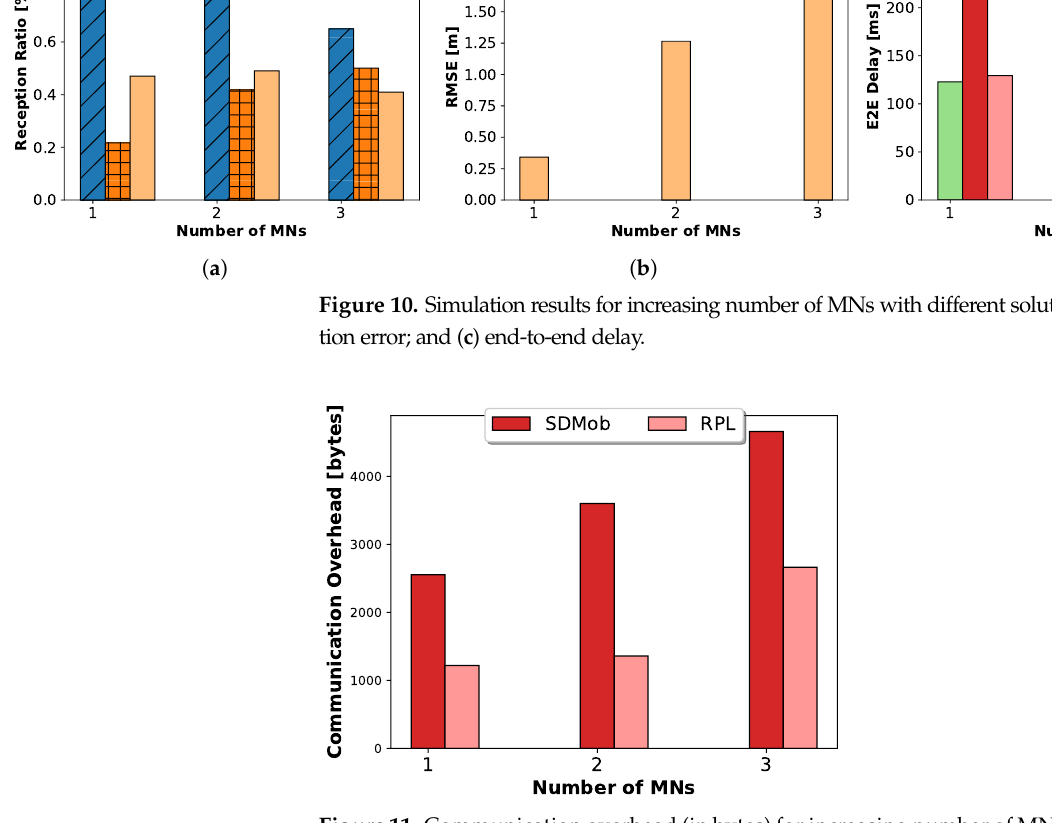
Figure 11. Communication overhead (in bytes) for increasing number of MNs with different solutions.